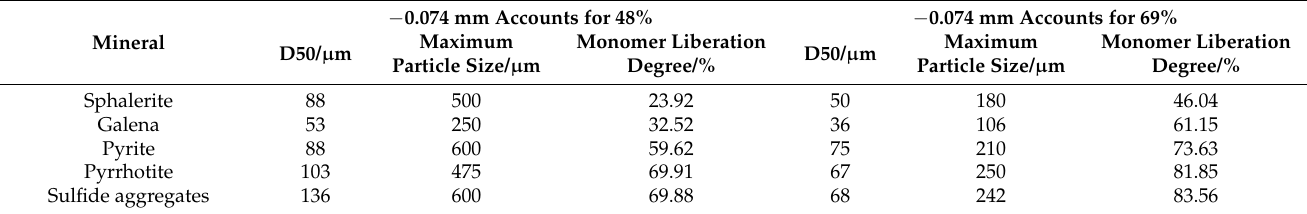
Table 4. Dissociation characteristics of major metal minerals under two kinds of grinding